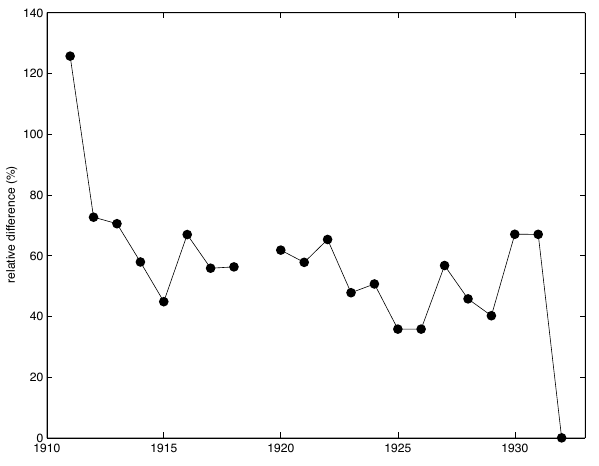
Fig. 3. Relative differences between the IHV-raw values calcu- lated from the yearbooks and WDC data for Januaries in 1911–1932 (yearbook data in 1919 were missing).